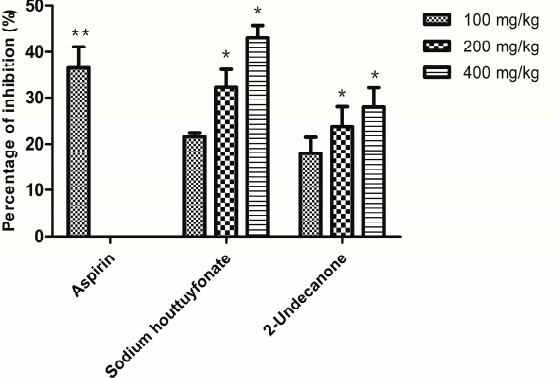
Figure 4. Anti-inflammatory effects of sodium houttuyfonate and 2-undecanone on xylene-induced mouse ear edema. Aspirin is used as the positive control. Data represent the mean of the difference in percentage of inhibition (%) ( n = 10). ** p < 0.01, * p < 0.05 vs. the model